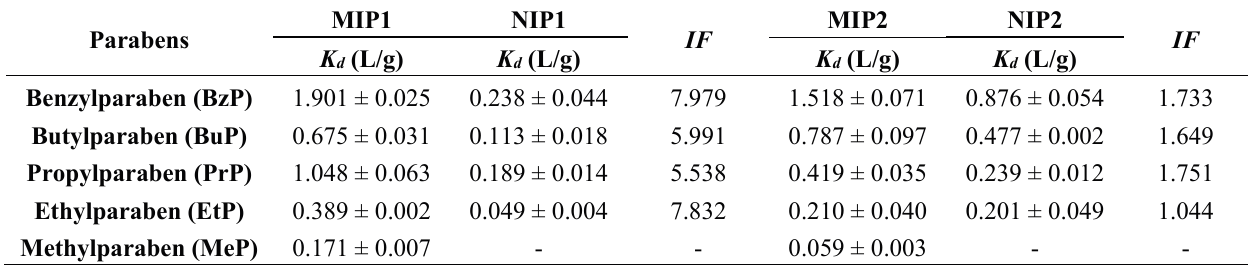
Table 3. K d and IF values of the parabens on polymers. “-” means the test was done but the datum could not be calculated; results based on three replicate analyses for all